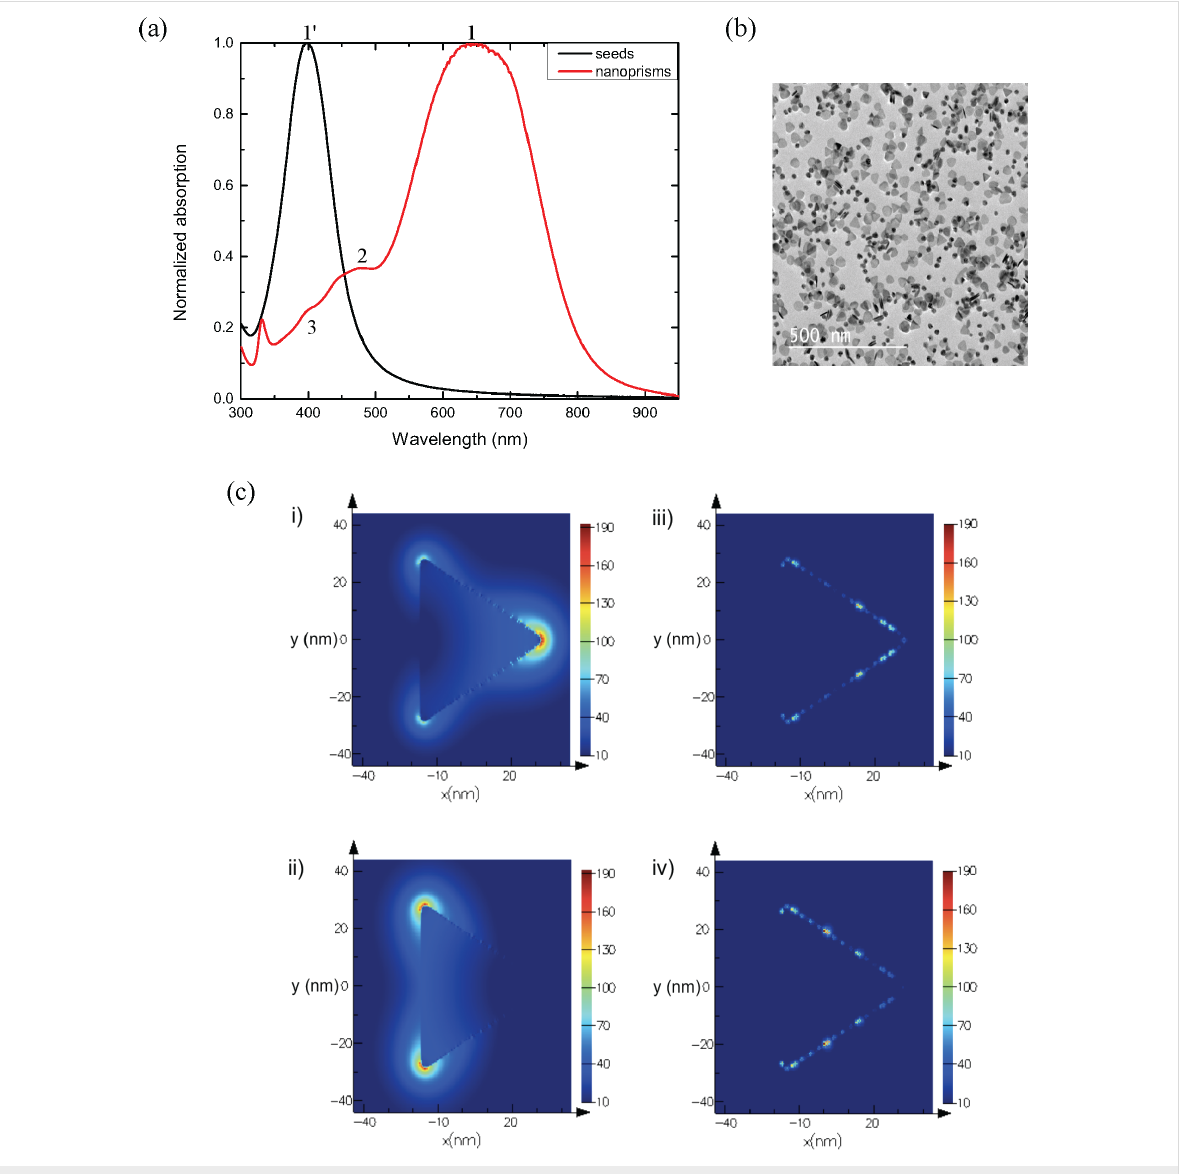
Figure 1: a) Normalized absorption of nanosphere and nanoprism solutions. b) TEM image of the synthetized nanoprisms before centrifugation and c) visualization of the electric field enhancement normalized to the incident electric field in the nanoprism for wavelength of peak 1 under z -oriented (i) p-polarized light and (ii) s-polarized light, and for the wavelength of peak 2 under (iii) p-polarized light and (iv) s-polarized